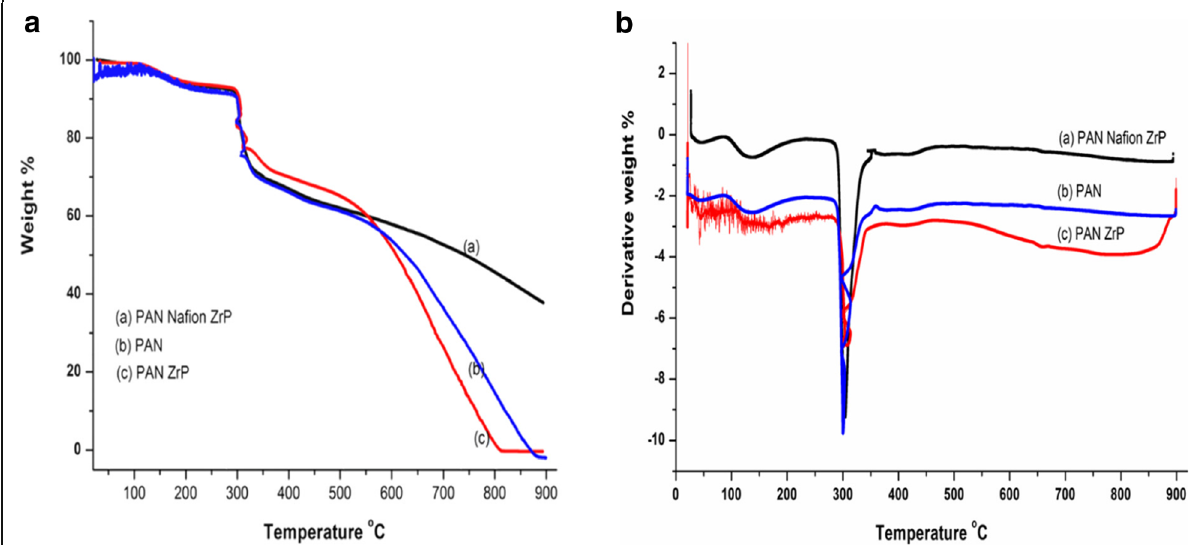
Fig. 6 a The thermal gravimetric analysis (TGA) and b derivative thermogravimetric (DTG) analysis of ( a ) PAN-Nafion/ZrP nanofibers, ( b ) PAN nanofibers and ( c ) PAN/ZrP nanofibers